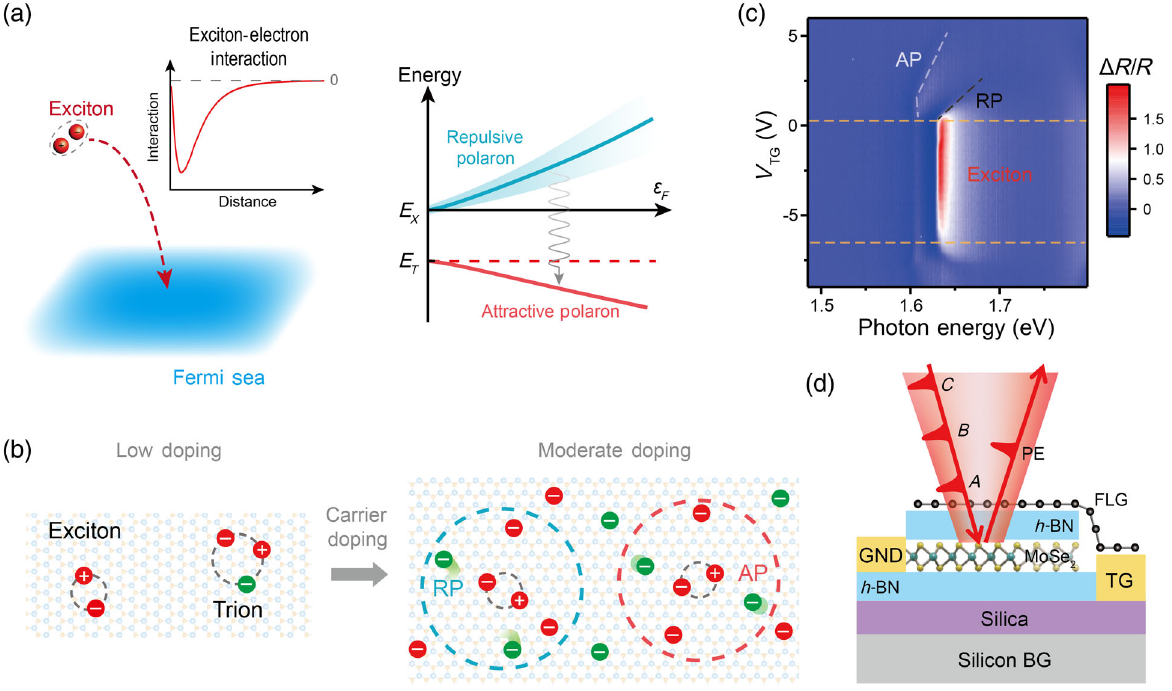
FIG. 1. Illustration of the MoSe 2 device and physical concept. (a) Schematic of Fermi polarons. When excitons are attractively coupled to a Fermi sea of electrons, the spectrum of the whole system splits into two branches: APs and RPs. In the limit of vanishing Fermi energy ε , the APs and RPs recover the energies of trions ( E ) and excitons ( E ), respectively. (b) Evolution from an exciton-trion F T X picture to a Fermi-polaron picture as the doping density increases in a monolayer. Spheres in red refer to electrons ( − ) and holes ( þ ) in one valley, while spheres in green color indicate the opposite valley. The displacement of electrons around the exciton in the moderate- doping regime represents the polaronic cloud of density fluctuations (particle-hole excitations). (c) Reflectance spectra from a doped MoSe 2 monolayer at different top-gate voltages ( V ). The dashed lines are guidelines for the evolution of APs (bright) and RPs (dark). TG (d) Schematics of a collinear 2DCES experiment performed on a monolayer MoSe 2 device. A train of three pulses ( A , B , C ) is focused onto the monolayer MoSe 2 , and the photon-echo (PE) signal is collected via the same microscope objective. The pulses are incident perpendicular to the sample but are illustrated here at an angle for